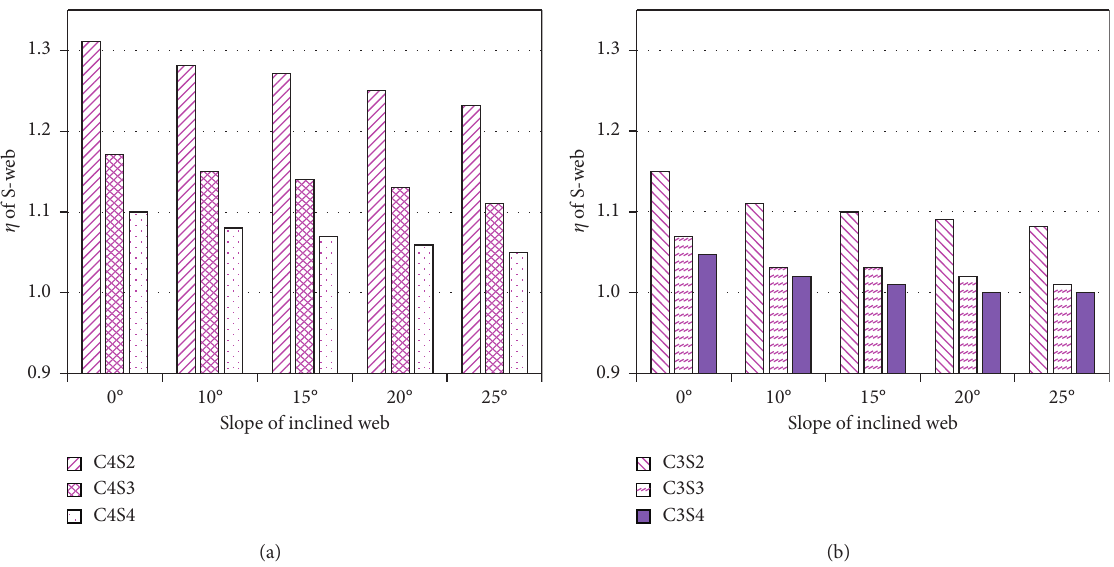
Figure 6: Effect of support condition. (a) C4S2, C4S3, and C4S4. (b) C3S2, C3S3, and C3S4.